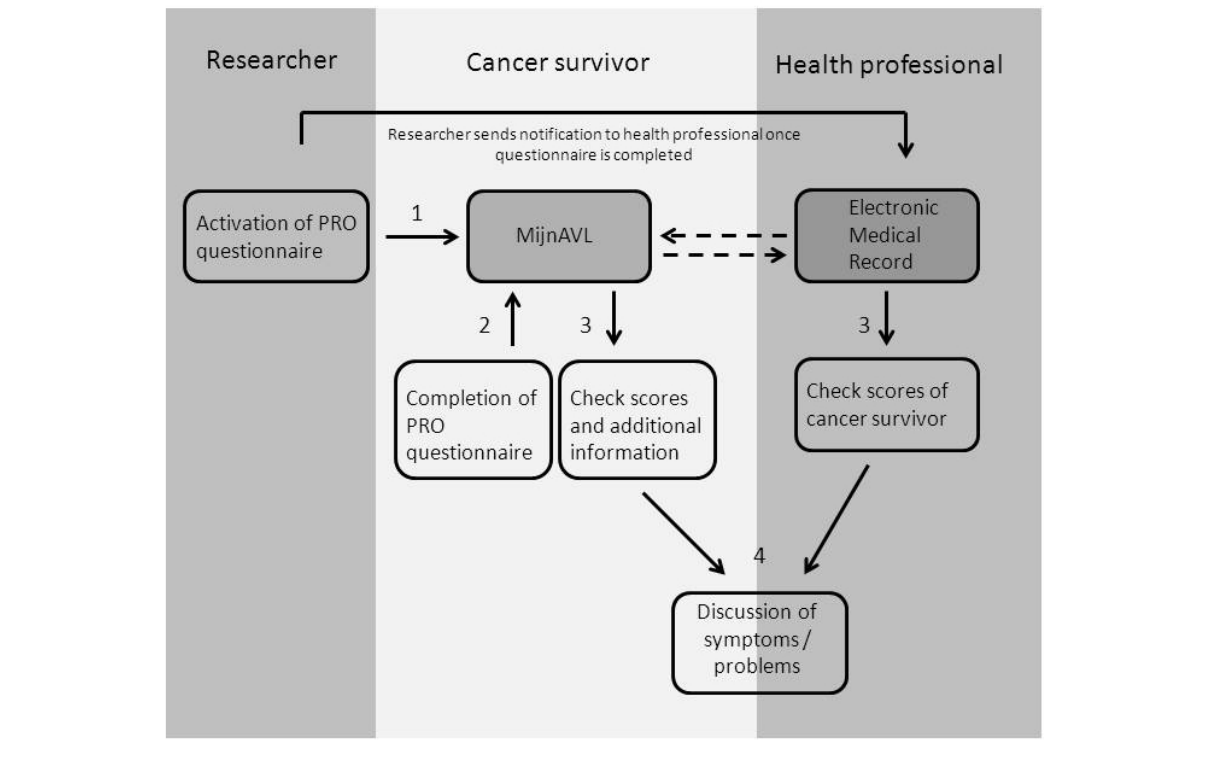
Figure 2. Interactive feature of MijnAVL: PROs.